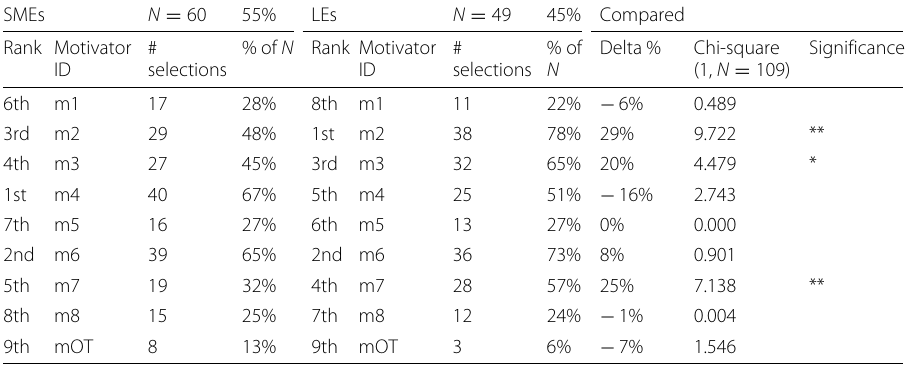
Table 11 Comparison of ranking of motivators for IoT application development and deployment for SMEs and LEs based on selection frequency